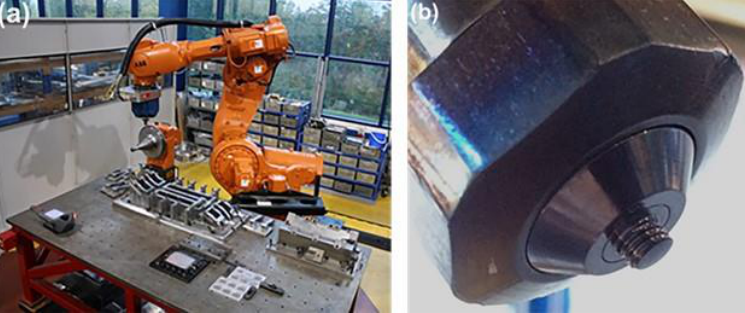
Figure 2. FlexiFab robotic FSW system at TWI ( a ) and SS-FSW tool setup ( b ).